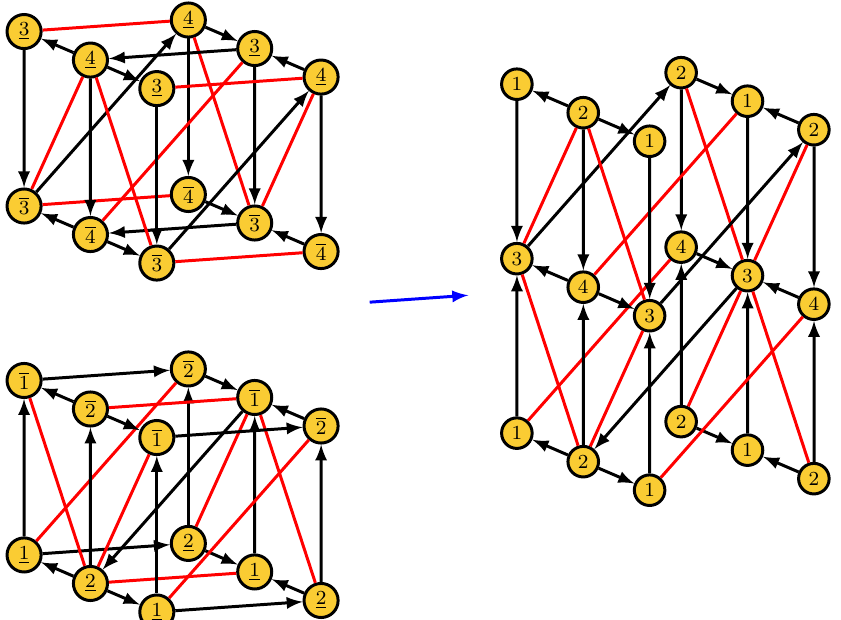
Figure 15. 3 d printing of the periodic quiver for Q 1 ; 1 ; 1 using two conifold quiver blocks.